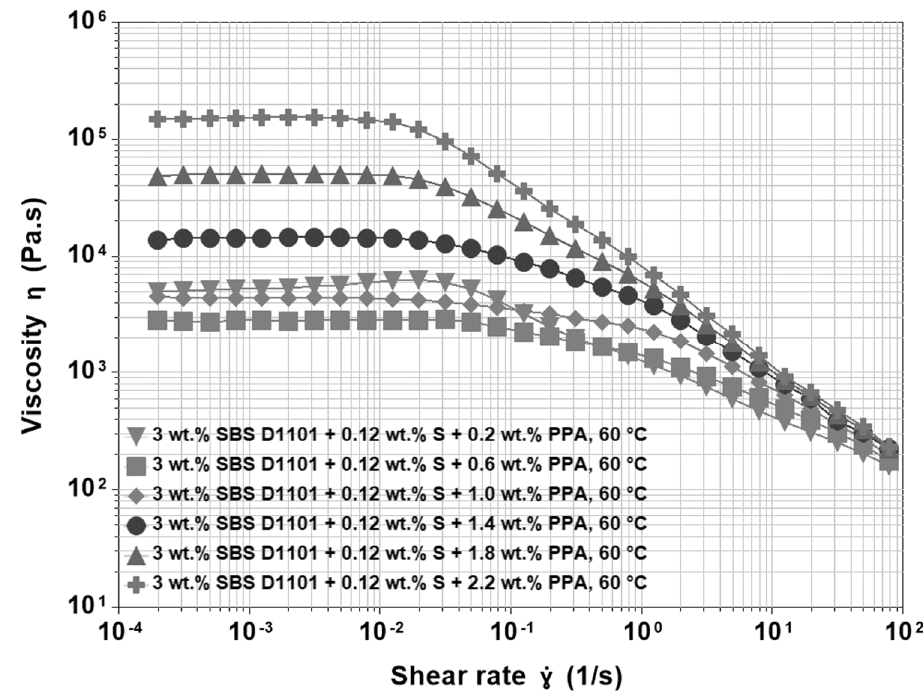
Figure 8. Viscosity functions at 60 °C for 200/300 Pen grade modified by 3 wt.% SBS D1101 crosslinked with 0.12 wt.% sulfur and PPA ranging from 0.2 wt.% to 2.2 wt.%.